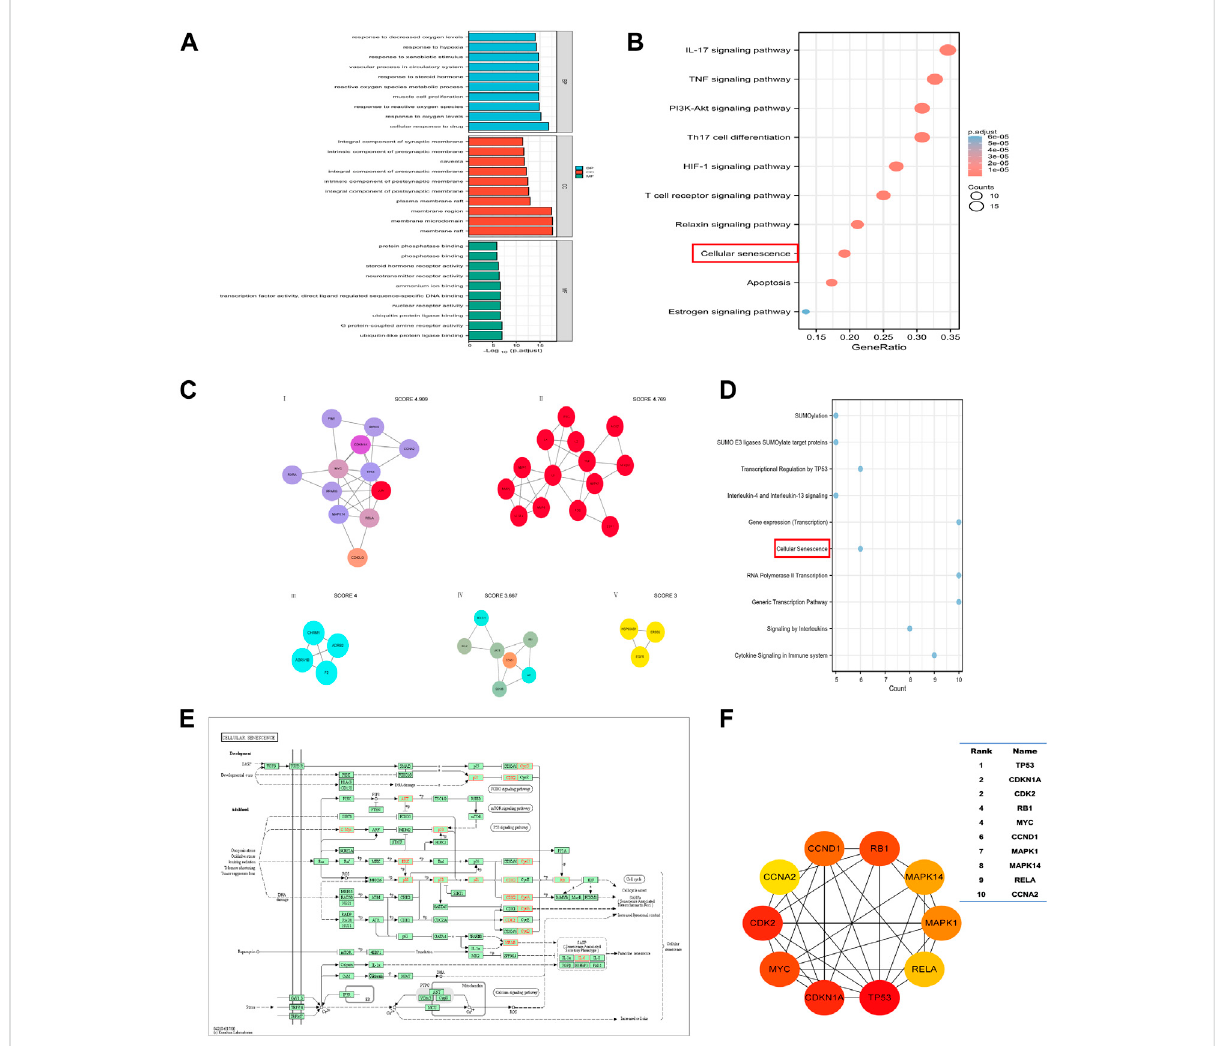
FIGURE 6 The critical pathways screened by network pharmacology. (A) GO enrichment analysis. (B) KEGG enrichment analysis. Cellular senescence signalingpathwayswereenrichedforthe fi rsttime. (C) The fi veclustersscreedbyMCODEanalysis. (D) Reactomepathwayenrichmentanalysisofthe cluster Ⅰ . The cellular senescence signaling pathway was again enriched. (E – F) The cellular senescence pathway and key markers (TP53/P53, CDKN1A/P21) on the